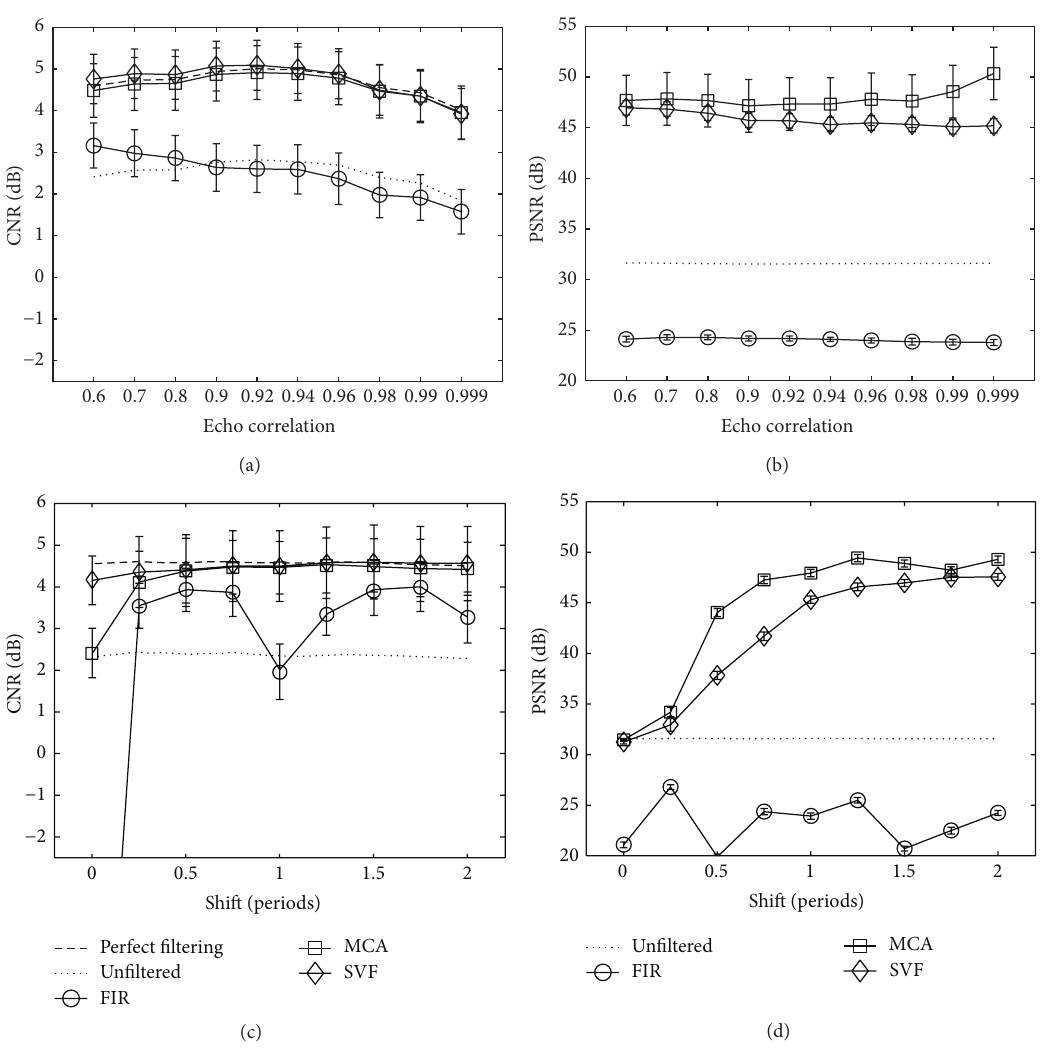
Figure 8: Mean CNR and mean PSNR measurements for MCA, SVF, and FIR methods for varied ((a) and (b)) echo correlation and ((c) and (d)) axial shift of the tissue scatterers. Markers represent the mean CNR and mean PSNR, respectively, and error bars the standard deviation over 100 simulations. The dashed line, labeled “perfect filtering,” represents the mean CNR when the clutter artifacts are not present in the simulated echo data. Likewise, “unfiltered” represents the CNR or PSNR of the measured data with clutter artifacts and when no filtering technique is